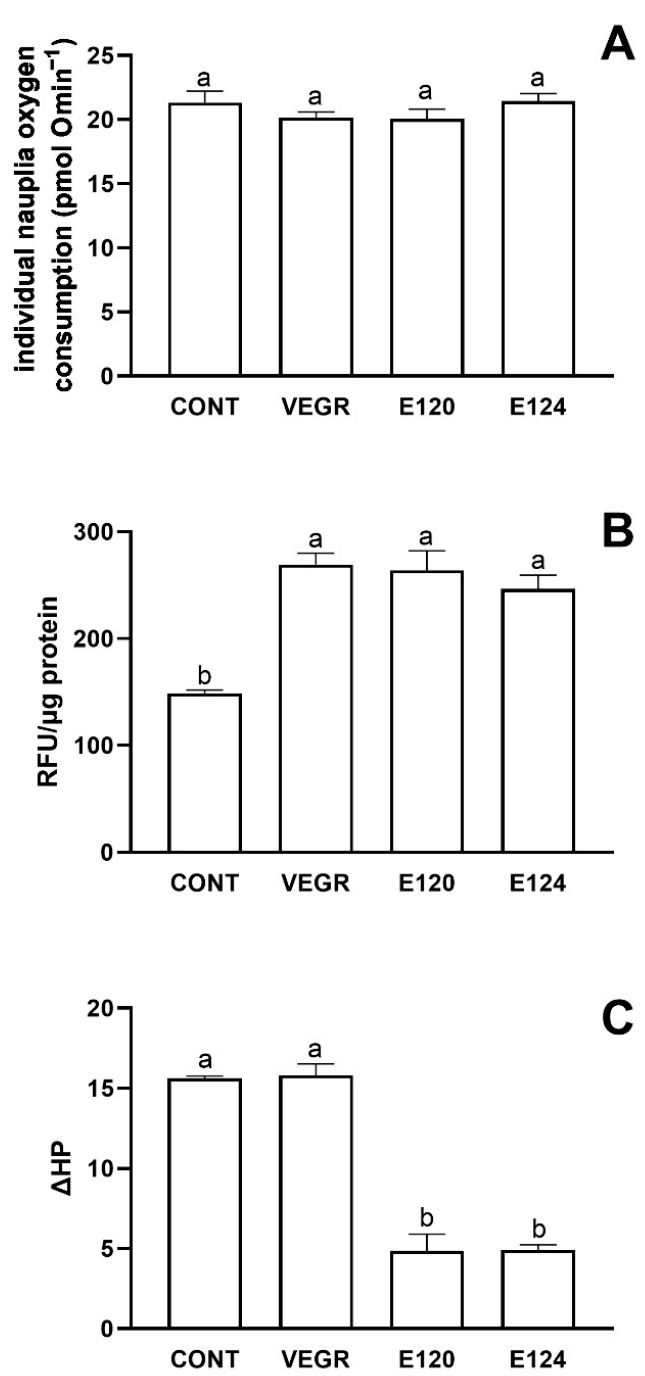
Figure 4. Effect of food dyes (VEGR, E120, and E124) exposition on: ( A ) in vivo routine oxygen consumption of 48 h Artemia salina nauplii; ( B ) ROS levels (expressed as Relative Fluorescent Units, RFU, per µ g protein) of homogenates of 48 h Artemia salina nauplii; ( C ) in vitro susceptibility to Fe 2+ -ascorbate-induced oxidative stress (measured as the level changes on the lipid-bound hydroper- oxide, ∆ HP, expressed as nmol NADPH min − 1 per mg protein) of homogenates of 48 h Artemia salina nauplii. Values are mean ± SEM ( n = 4). Different letters indicate statistically significant differences among